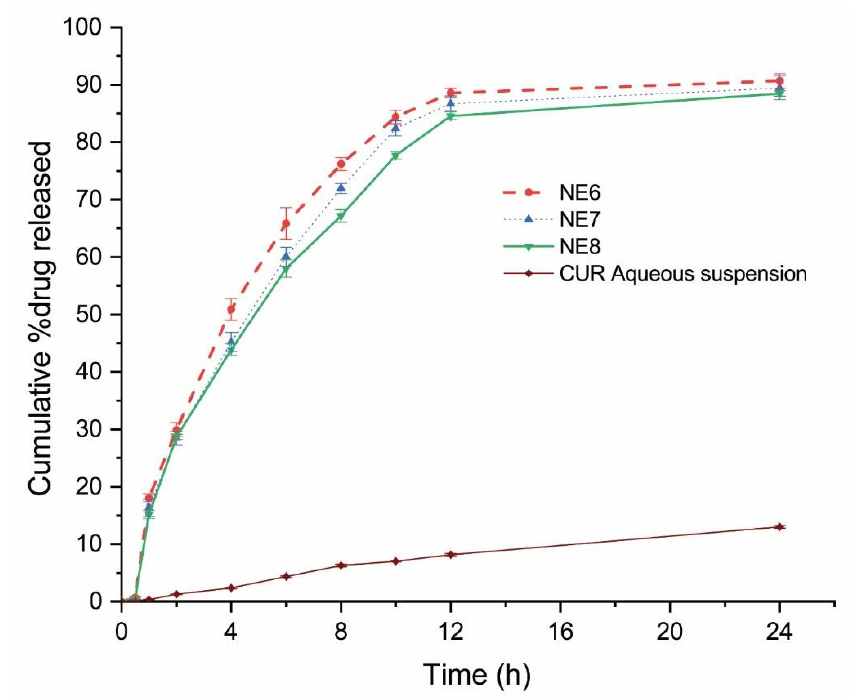
Figure 2. In vitro release of curcumin from curcumin-loaded NE (nanoemulsion) system.